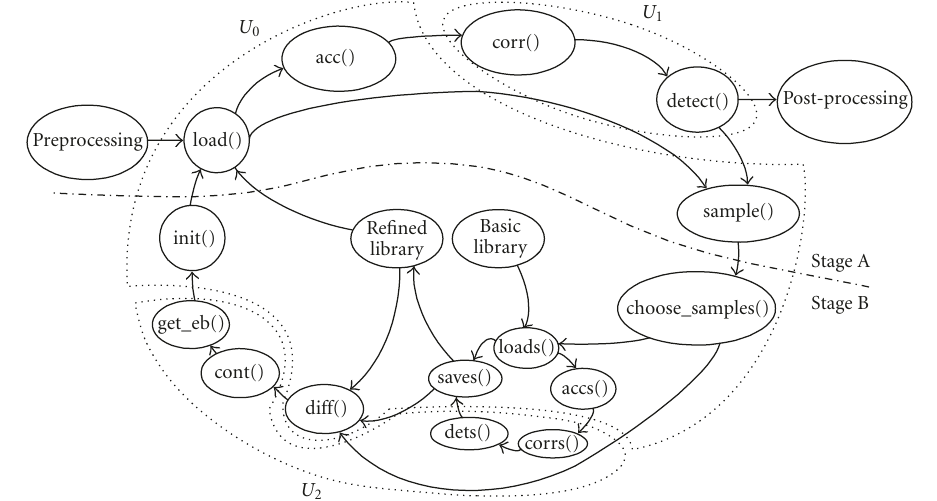
Figure 5: Illustration of functional